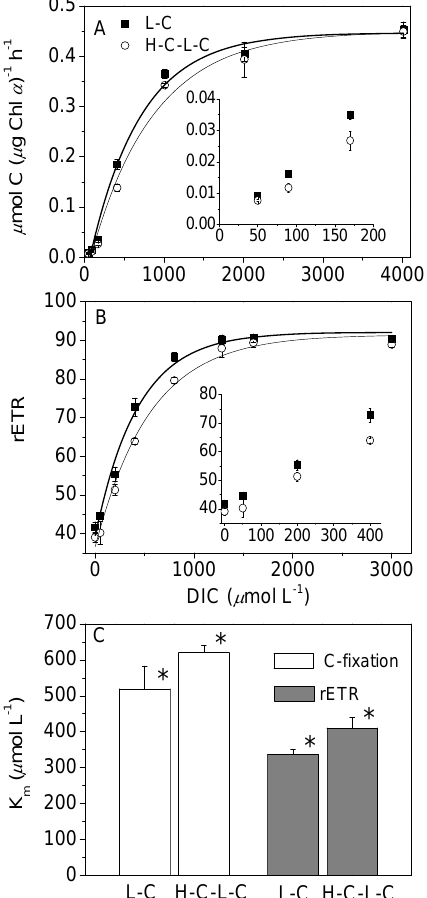
Fig. 3. (A) Photosynthetic carbon fixation rate, (B) rETR under photon flux densities of 400µmol m − 2 s − 1 as a function of DIC concentration, and (C) the DIC concentrations for the half-maximal photosynthetic rate for cells acclimated and measured under differ- ent CO 2 levels (L-C, H-C-L-C as given in legend to Fig. 2). Vertical bars represent SD, n